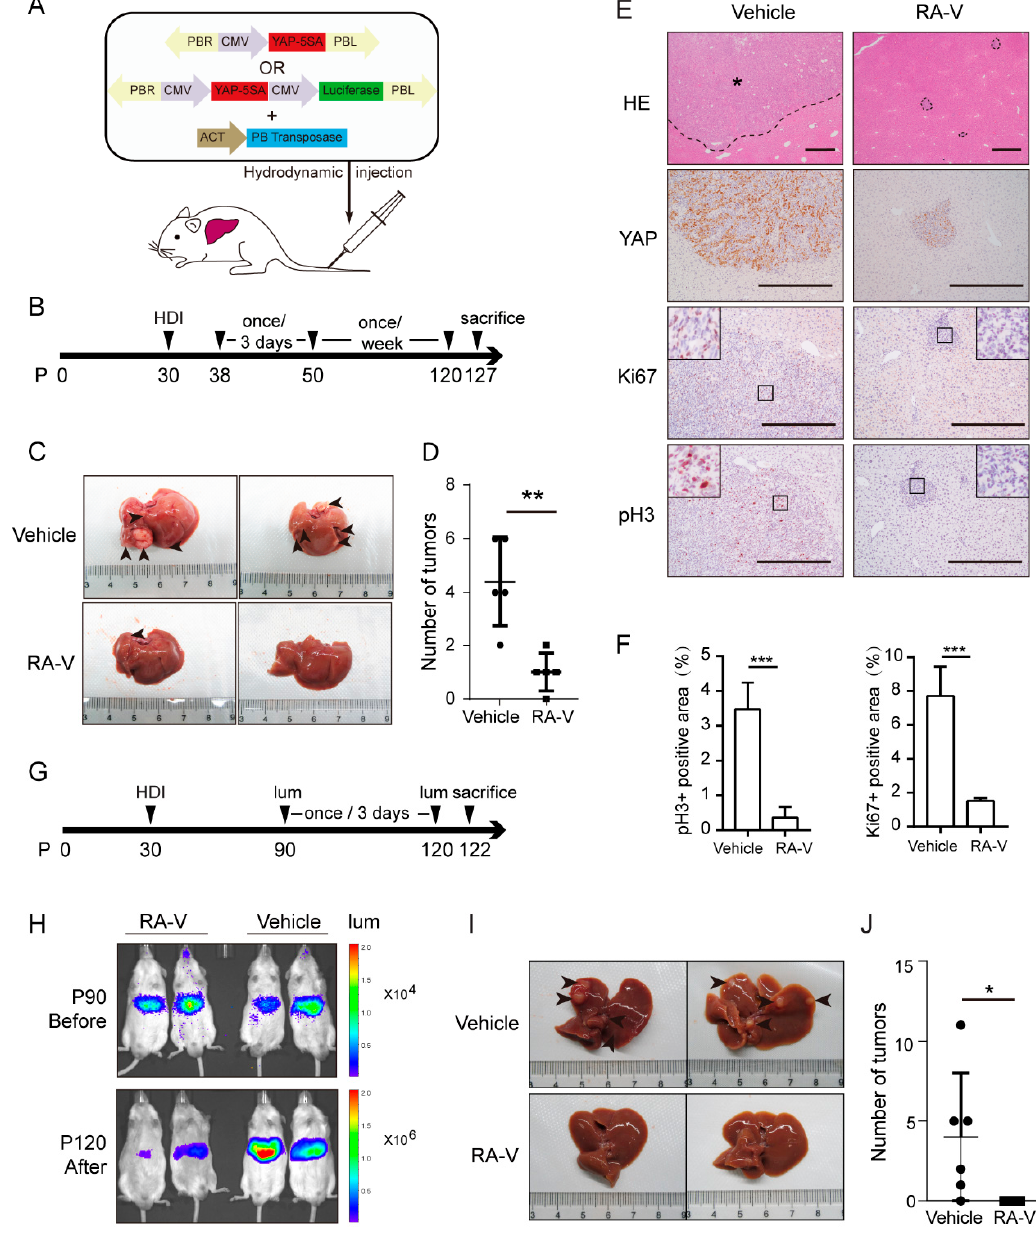
Figure 6. RA-V induces regression of liver tumors induced by YAP activation. ( A ) Scheme of liver tumorigenesis mouse model by hydrodynamic injection (HDI) of transposon plasmids. ( B ) Schedule of RA-V (5 mg/kg) injection. ( C , D ) RA-V inhibits liver tumorigenesis induced by expression of YAP-5SA. Images were representative livers from five mice ( C ). Arrowheads indicate tumors. Observable tumors were quantified ( D ). Values represent mean ± SD with all data points plotted. p values were determined by Student’s t test. **, p < 0.01. ( E , F ) RA-V markedly reduces lesion size and proliferation. Respective liver sections were stained ( E ), and cell proliferation was quantified by calculating the area of pH3/Ki67 positive signals relative to lesion area from eight fields by ImageJ ( F ). Scale bars, 500 µ m. Asterisk denotes tumor. Values represent mean ± SD. P values were determined by Student’s t test. ***, p < 0.001. ( G ) Schedule of RA-V (10 mg/kg) treatment. ( H – J ) RA-V induces tumor regression. Mouse models were established and treated as in ( G ). Bioluminescence imaging was performed before and after RA-V treatment. Two representative mice from each group were shown ( H ). Livers were also dissected and pictured ( I ). Observable tumors were quantified ( J ). Values represent mean ± SD with all data points plotted. P values were determined by Student’s t test. *, p < 0.1.